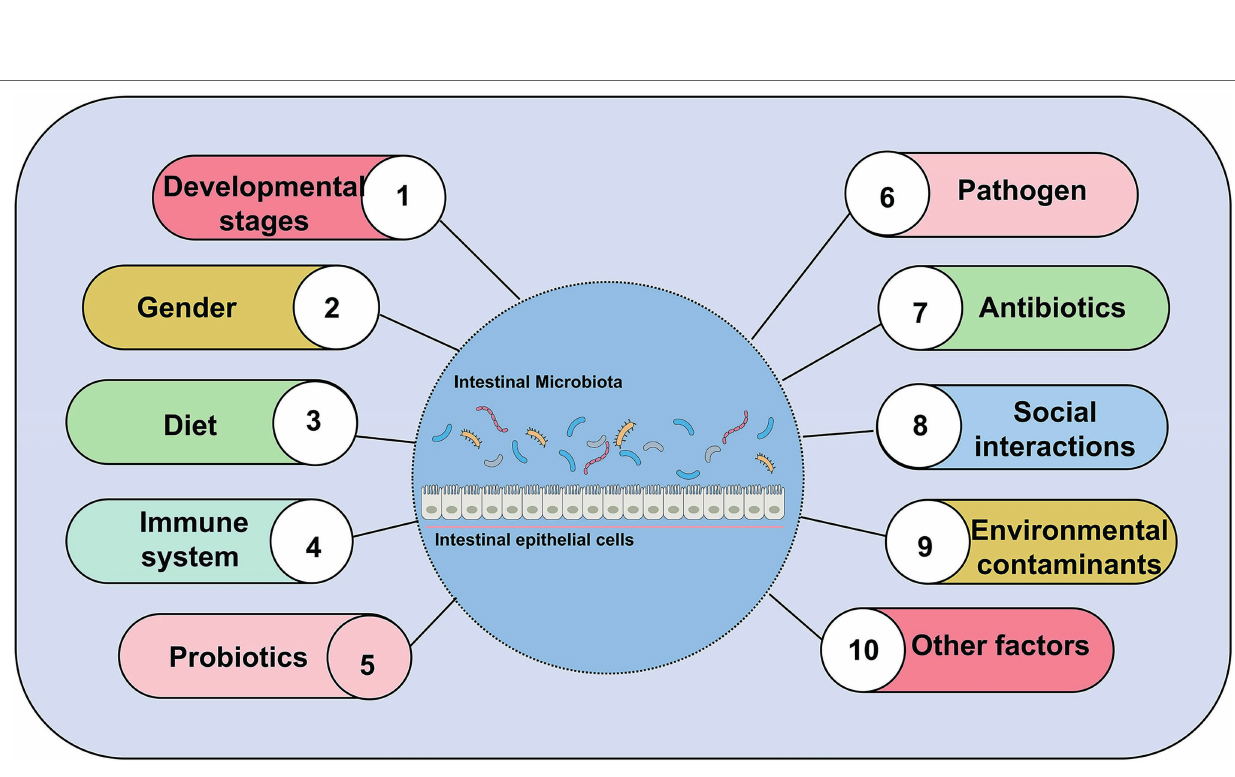
FIGURE 3 | Major factors affecting gut microbial composition, abundance, and diversity, excluding